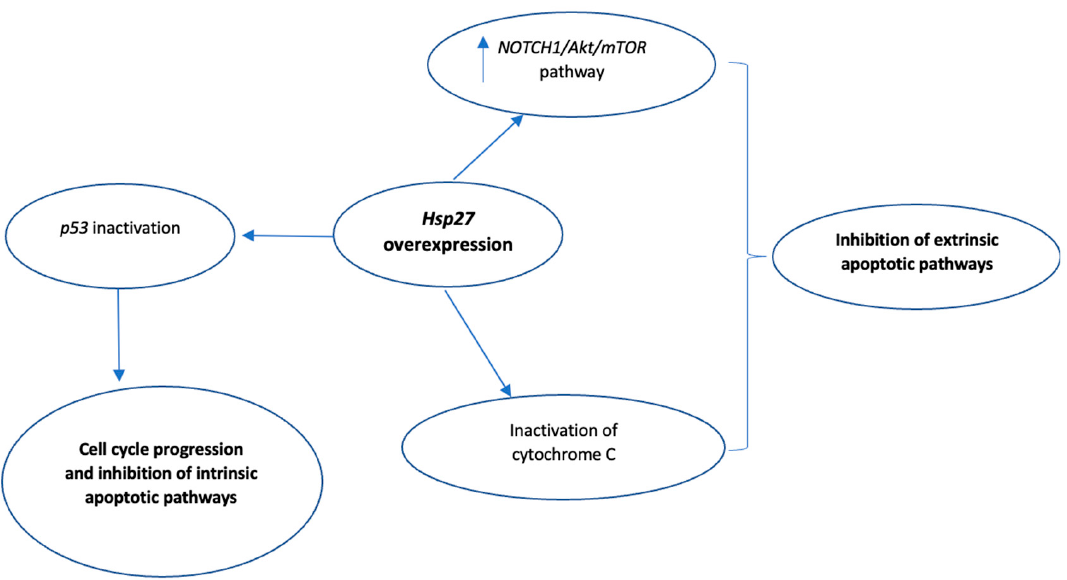
Figure 7. Summary of the molecular mechanisms of Hsp27-mediated resistance against 5-Fluorouracil (5-FU). Inhibition of both intrinsic and extrinsic apoptotic pathways play a key role in the 5-FU resistance. Key: NOTCH1, notch homolog 1; mTOR, mammalian target of rapamycin.